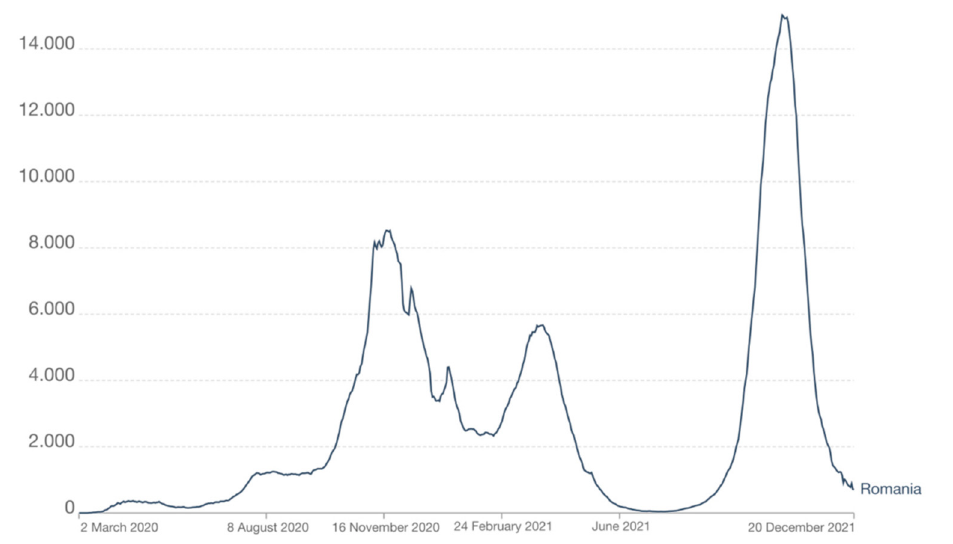
Figure 1. Evolution of the number of patients newly diagnosed with COVID-19 in Romania (Reprinted from Ref. [8]).